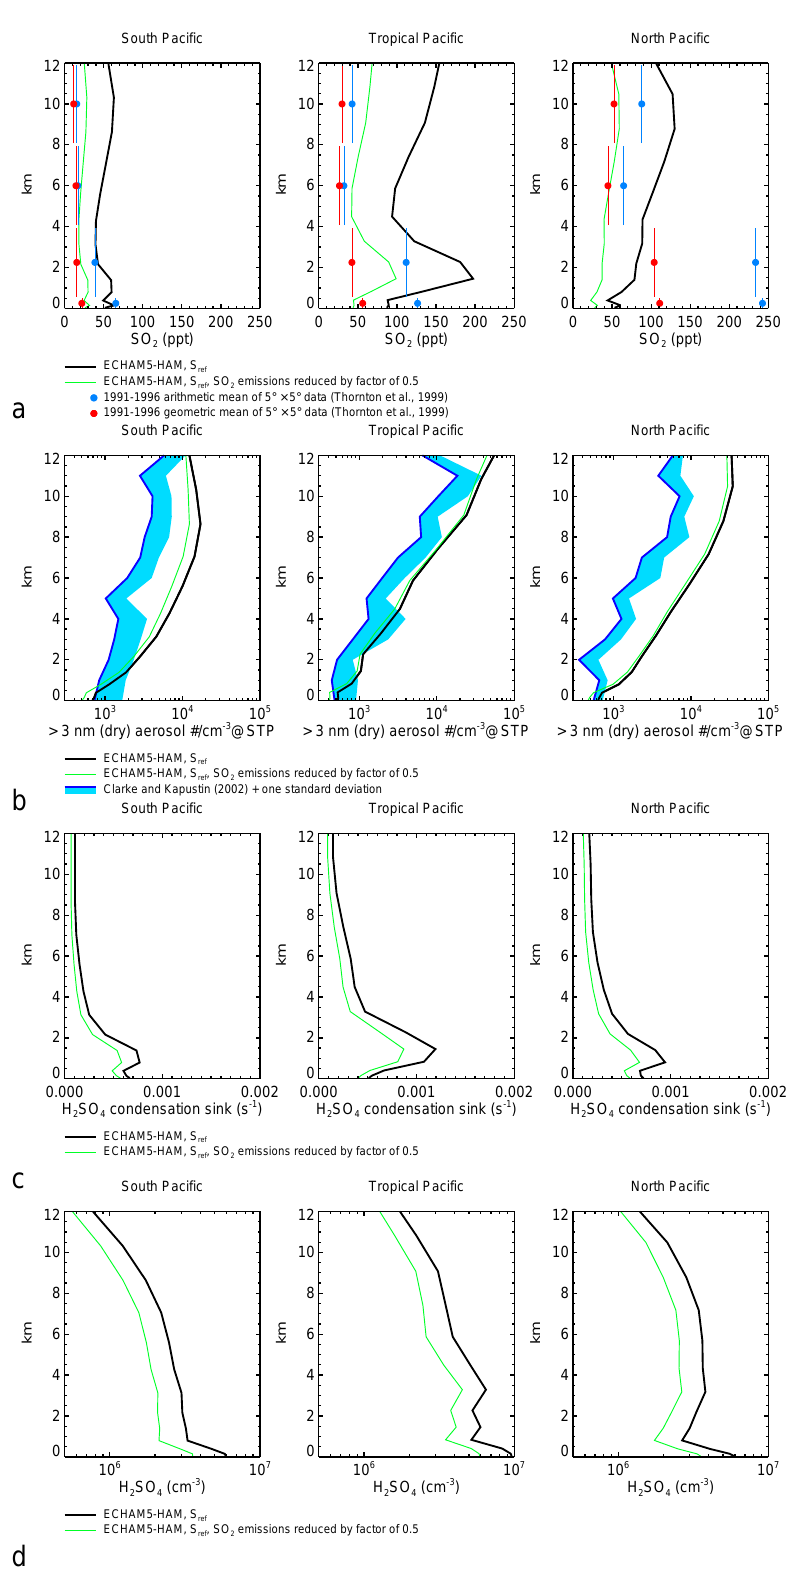
Fig. 2. Annual mean model results from simulation S ref with default SO 2 emissions (black) and emissions reduced by a factor of 0.5 (green) in three regions of the Pacific Ocean. (a) SO 2 number mixing ratio. (b) Ultrafine aerosol concentration. (c) H 2 SO 4 condensation sink. (d) H 2 SO 4